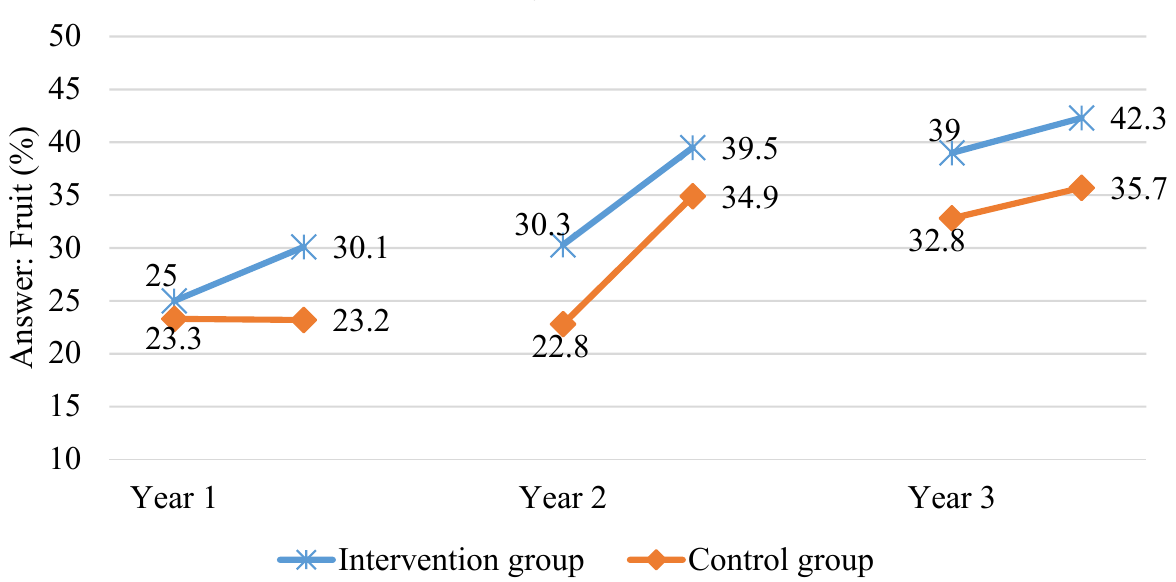
Figure 7. The proportion of children indicating fruit as products they like to eat during the three years of the study.